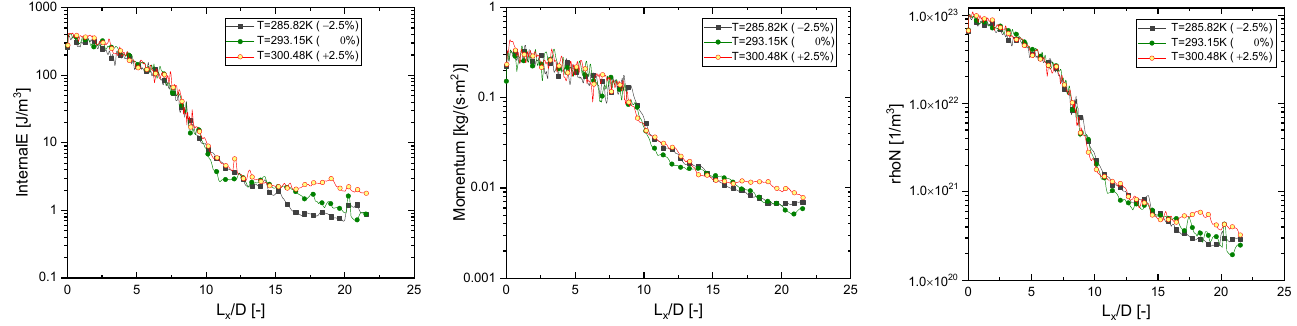
Figure 18. Molecular momentum distributions in nozzle at different gas temperatures at t = 0.1 ms.